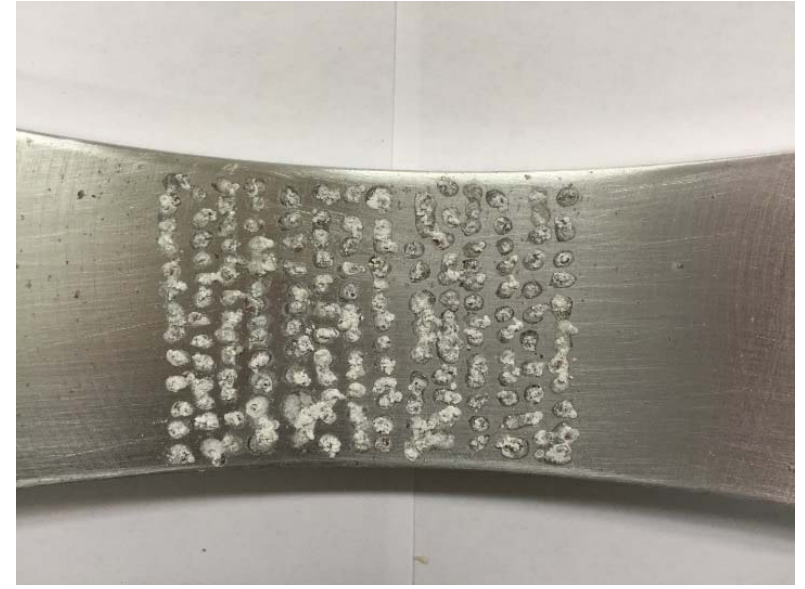
Figure 23. View of a typical surface.